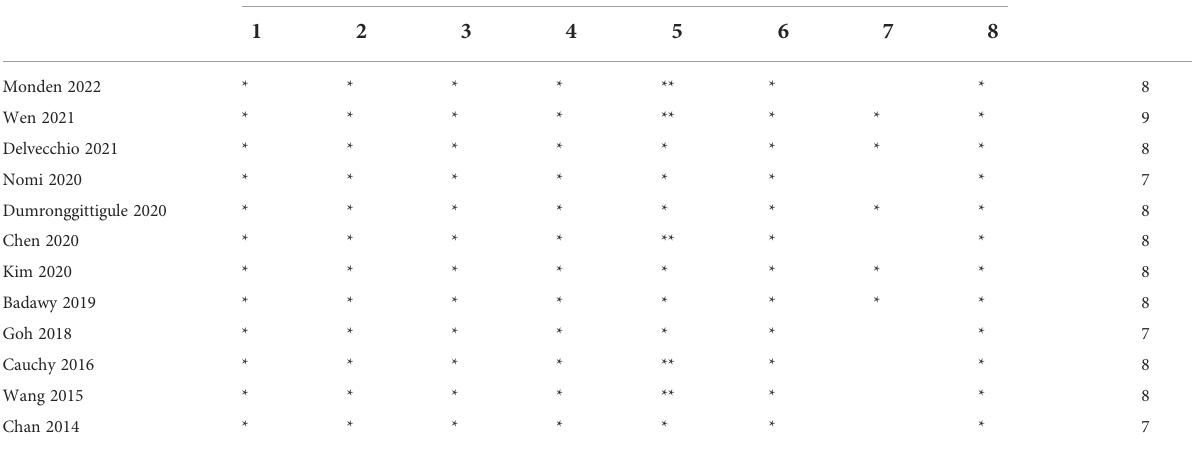
TABLE 2 Quality assessment of the included studies by the Newcastle – Ottawa